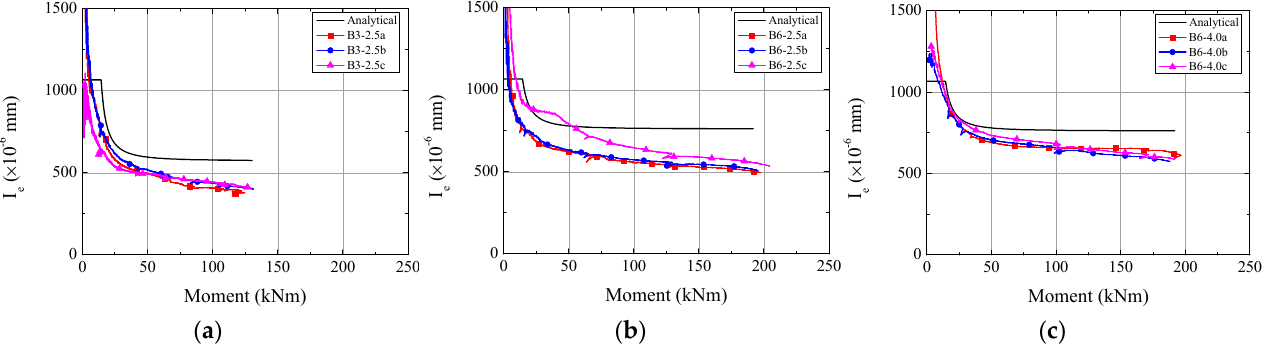
Figure 6. Moment versus effective moment of inertia relationships: ( a ) B3-2.5 series; ( b ) B6-2.5 series; ( c ) B6-4.0 series.